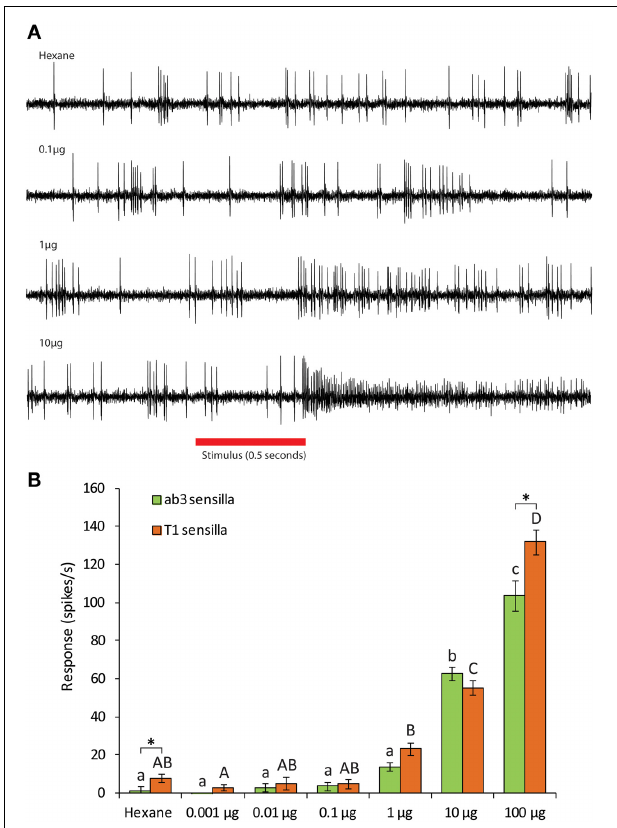
FIGURE 4 | (A) Traces of single sensillum recordings from D. melanogaster T1 sensilla expressing CpomOR3 to pear ester at different doses. (B) Dose-dependent response of CpomOR3 to pear ester in different types of sensilla. Bars of the same color followed by different letters indicate subgroups with statistically significant differences. Asterisks denote significant differences among different types of sensilla for the dose indicated (Two-Way ANOVA with Tukey’s post-hoc test, p < 0 . 05, n =